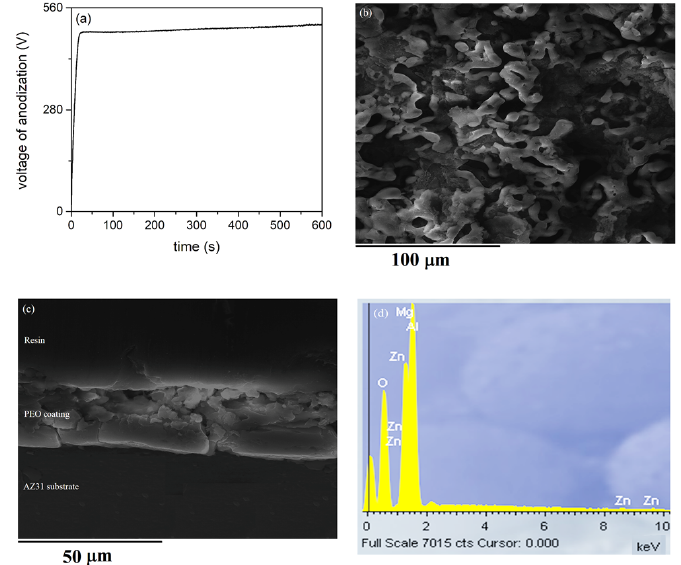
Figure 1. ( a ) Voltage–time curve during anodization of AZ31 magnesium alloy in 5 g/L NaAlO 2 at 150 mA/cm 2 ; ( b ) top-view SEM micrograph of MgAl coating; ( c ) cross-sectional SEM micrograph of MgAl coating; ( d ) EDS spectrum of MgAl coating.